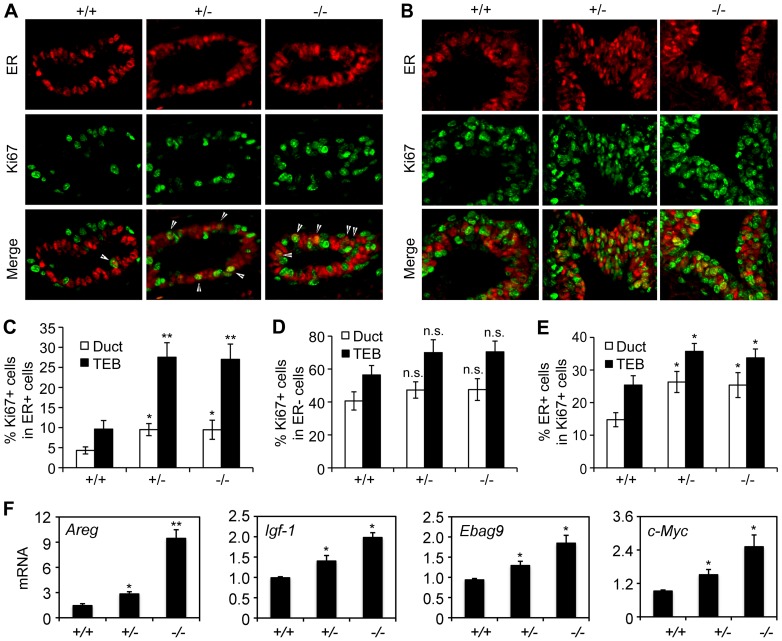

Atbf1-knockout-mediated cell proliferation primarily occurs in ER-positive cells.(A, B) Detection of ER (red) and Ki67 (green) by double IF staining in mammary ducts (A) and TEBs (B). White arrows indicate cells that are positive for both ER and Ki67. (C, D) Knockout of Atbf1 increases cell proliferation in ER-positive cells (C) but not in ER-negative cells (D). (E) Knockout of Atbf1 also increases the number of ER-positive cells among proliferating (Ki67-positive) cells. For panels C–E, cells were counted from 10 randomly selected fields per mouse, and three mice were used for each genotype. The number of cells counted for each bar ranged from 1000 to 2000 for ducts and 2000 to 2500 for TEBs. *, P<0.05; **, P<0.01; n.s., P>0.05 (one-way ANOVA). (F) Real time RT-PCR was used to detect ER target gene expression (Areg, Igf-1, Ebag9 and c-Myc).